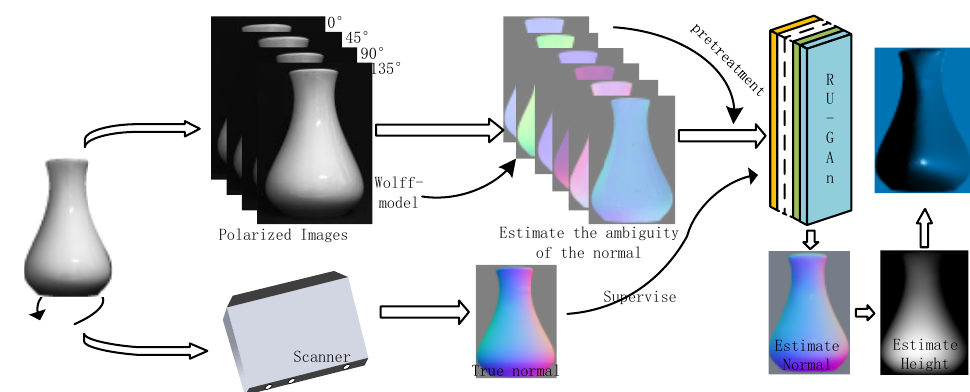
Figure 1. The proposed reconstruction framework.